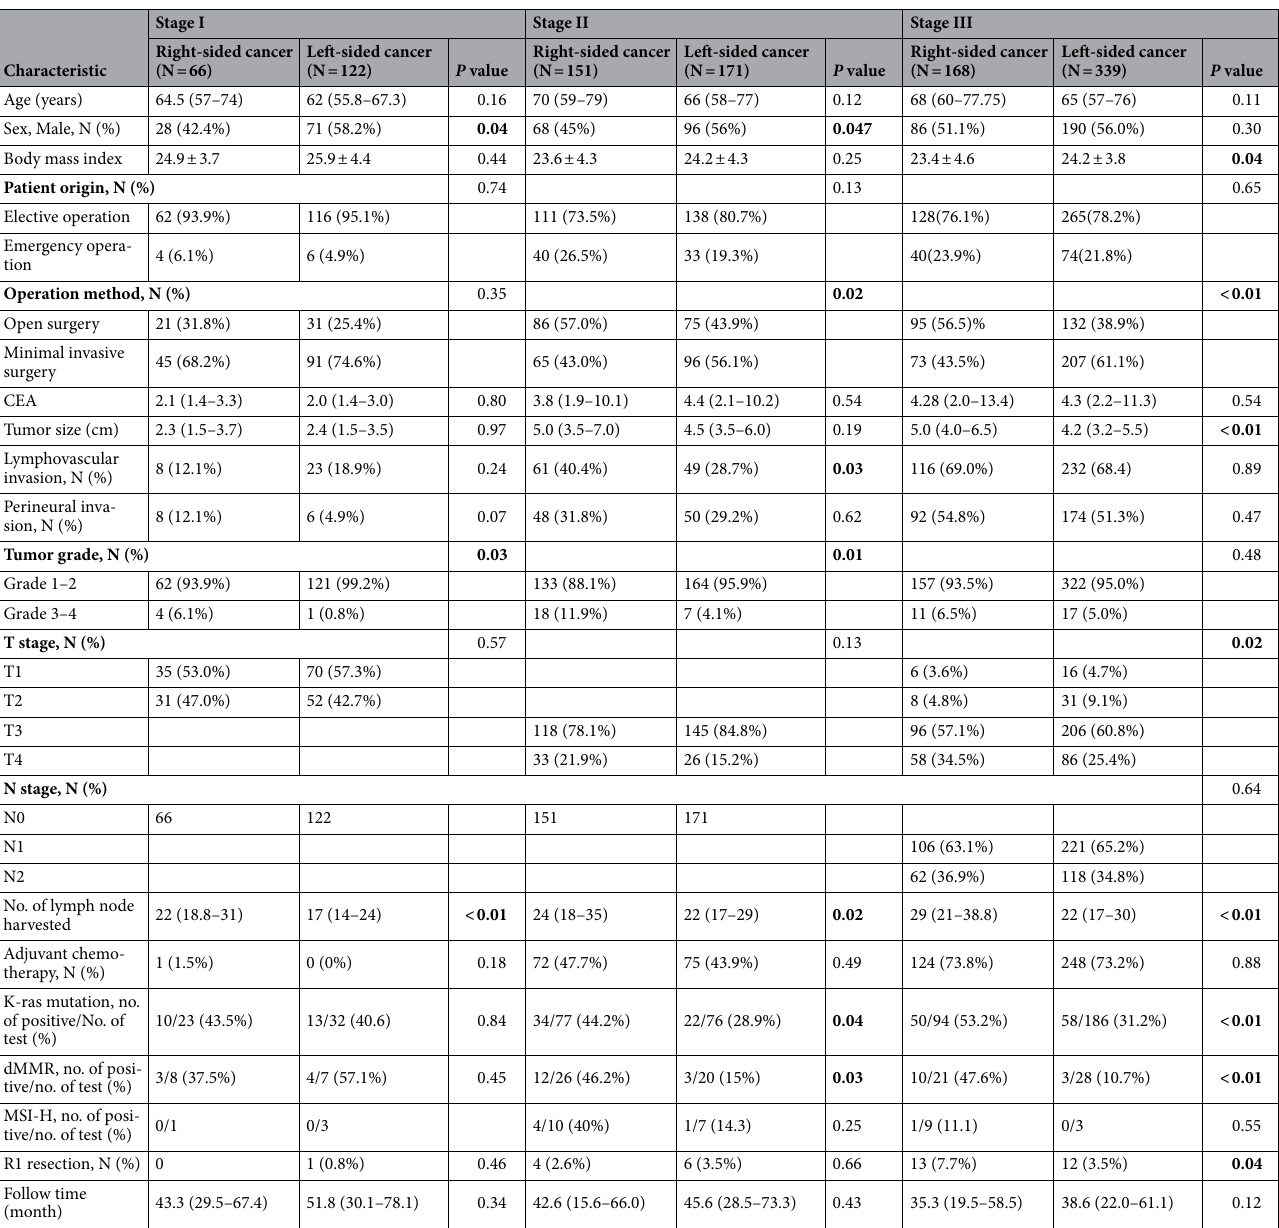
Table 2. Comparison of clinicopathological characteristics between right-sided and left-sided in stage I, II and III colon cancer. Significant values are in bold. CEA carcinoembryonic antigen, dMMR Deficient mismatch repair, MSI-H microsatellite